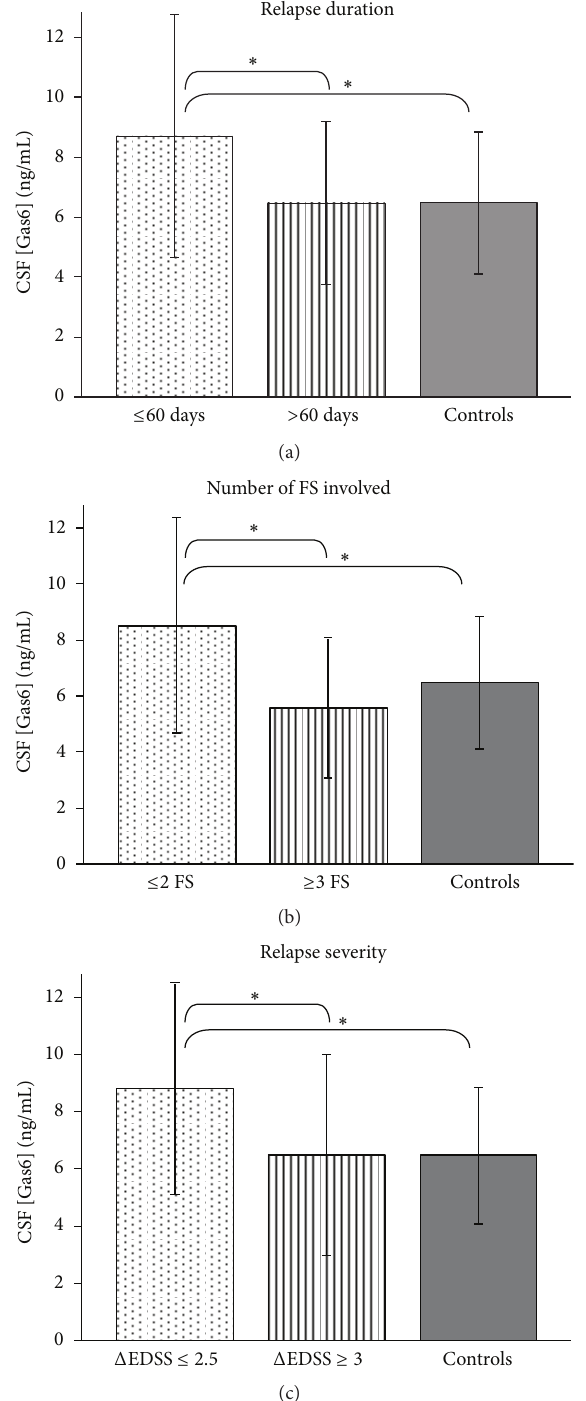
Figure 2: Gas6 concentration in CSF of patients with MS in relation to relapse features. The graph shows means and standard deviations of CSF Gas6 concentrations in relation to relapse duration: ≤ 60 days (dots), > 60 days (vertical lines) and controls (gray) (panel a); number of FS involved during the relapse: ≤ 2 (dots), ≥ 3 (vertical lines) and controls (gray) (panel b); and EDSS score variation at maximum worsening (severity): ≤ 2.5 (dots), ≥ 3 (vertical lines) and controls (gray) (panel c). ∗ indicates 𝑃 ≤ 0.05 in statistical comparison of the means (Tukey’s post hoc test).